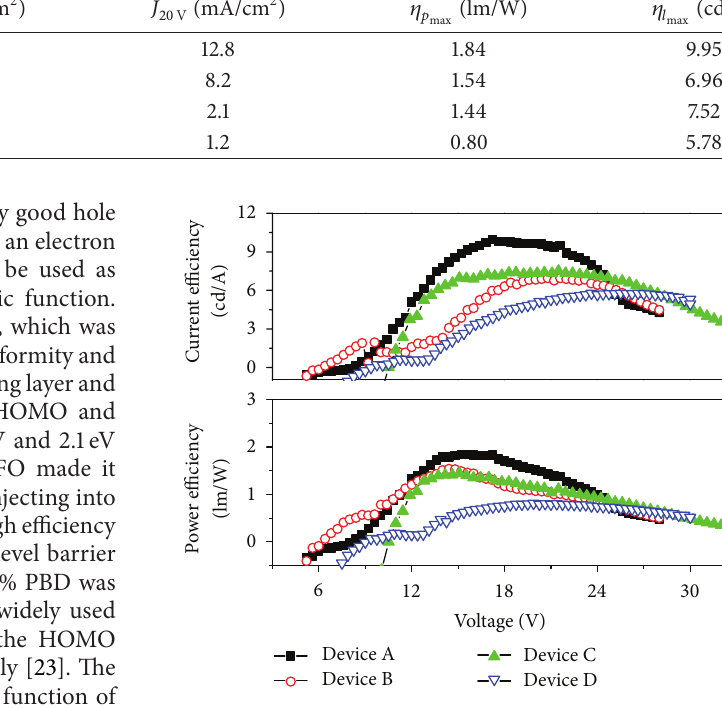
Figure 5: The power efficiency and current efficiency of four doping devices at different